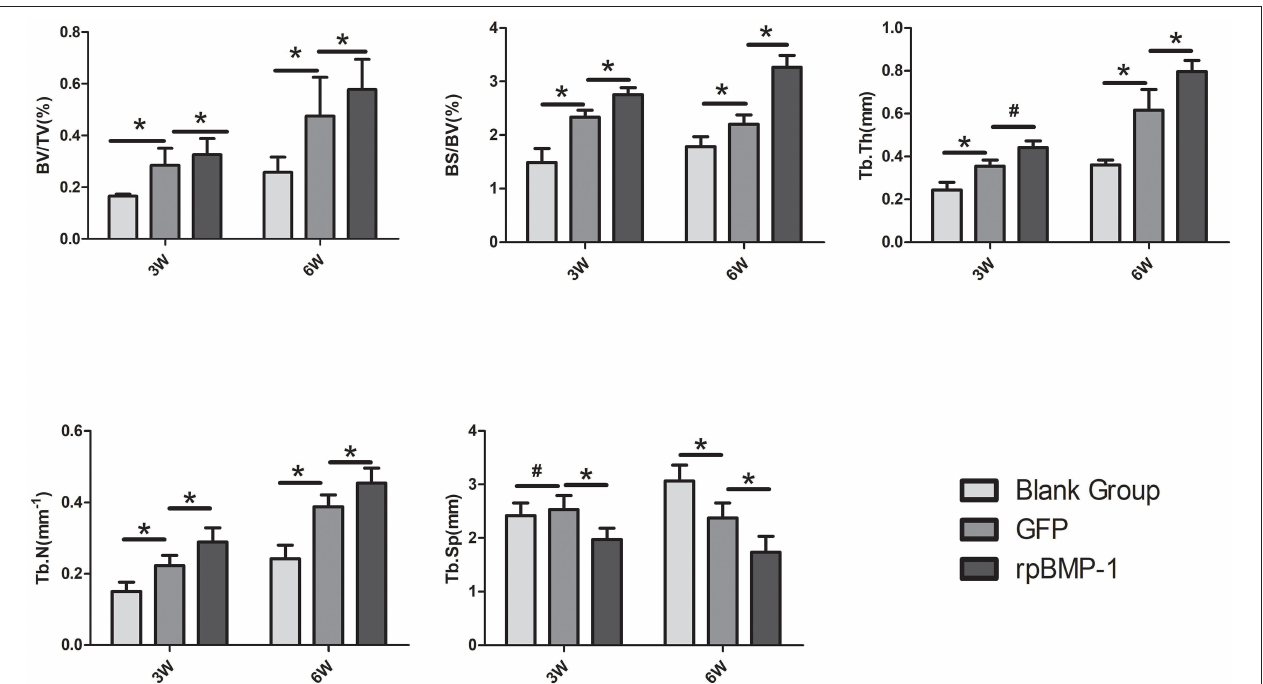
FIGURE 6 | Quantification analysis of osteogenic indicators in the distraction osteogenesis (DO) region of the mandible by Micro-CT (micro-computed tomography) in the blank control (group A), the green fluorescent protein (GFP) (group B), and the bone morphogenetic protein 1 (BMP-1) (group C) at three and six weeks of fixation. TbTh, the mean trabecular thickness; TbSp, the mean trabecular spacing; BS/BV, the new bone surface area/new bone volume; BV/TV, new bone volume/total new tissue volume; TbN, the mean trabecular number. * P < 0.05; # P > 0.05. were consistent with the results observed by Micro-CT.